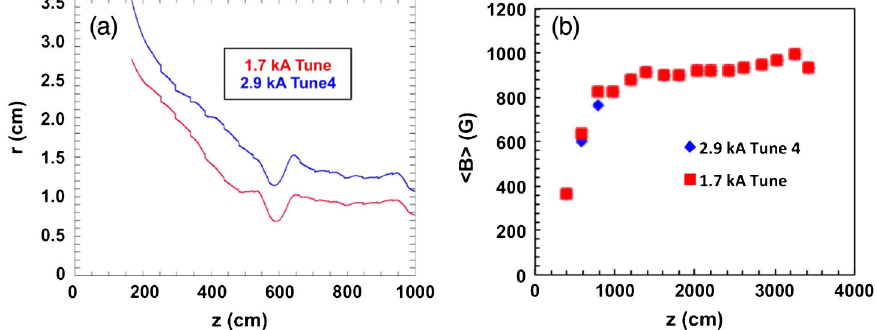
FIG. 4. (a) Calculated envelope comparison between the nominal 1.7 kA beam (red) and the first attempt at transporting the 2.9 kA beam (blue) in the first two cell blocks and (b) h B i for four cells in each cell block for both tunes.